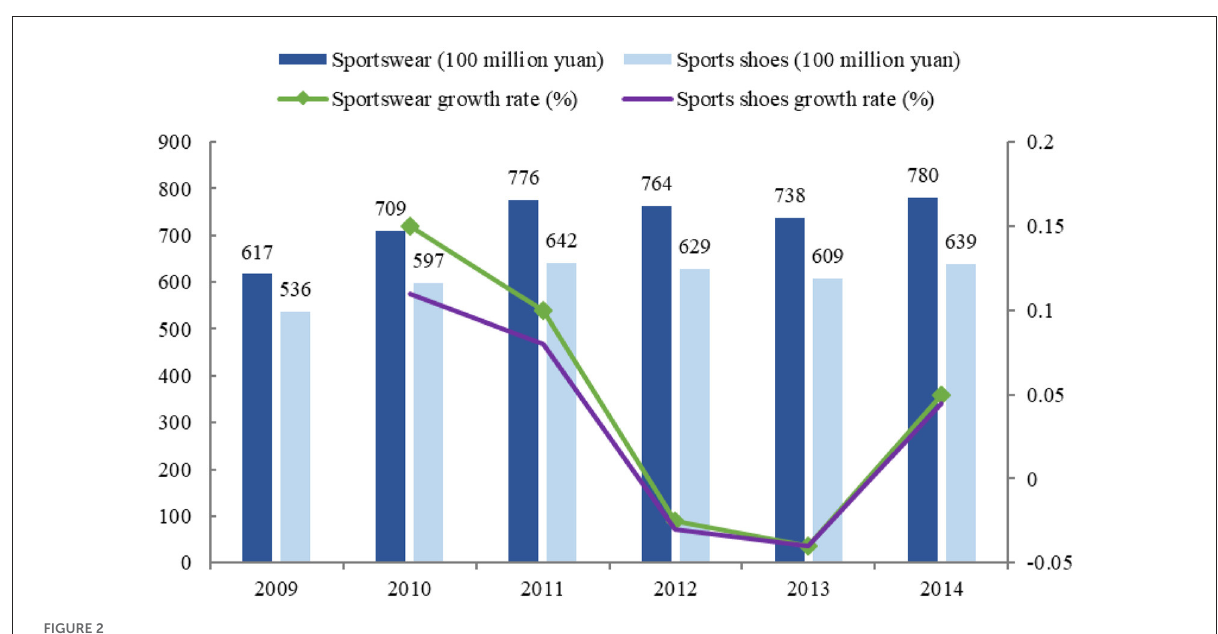
FIGURE1 Sports field.